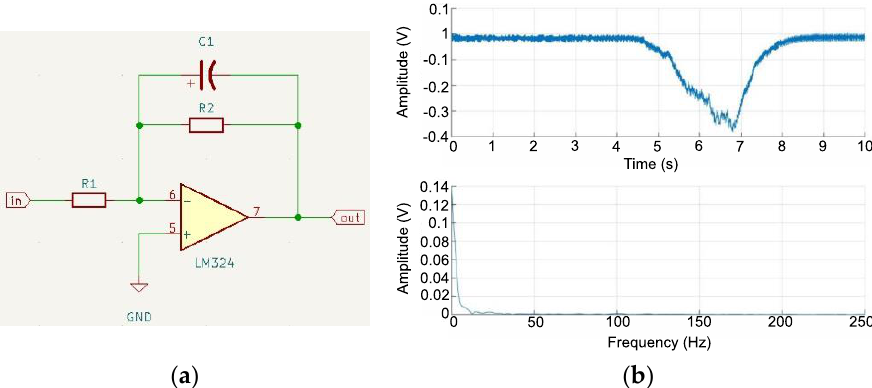
Figure 7. Connection diagram of LM324 operational amplifier in configuration of the first-order low-pass filter ( a ), time and frequency diagram of signal after low-pass filtering ( b ).